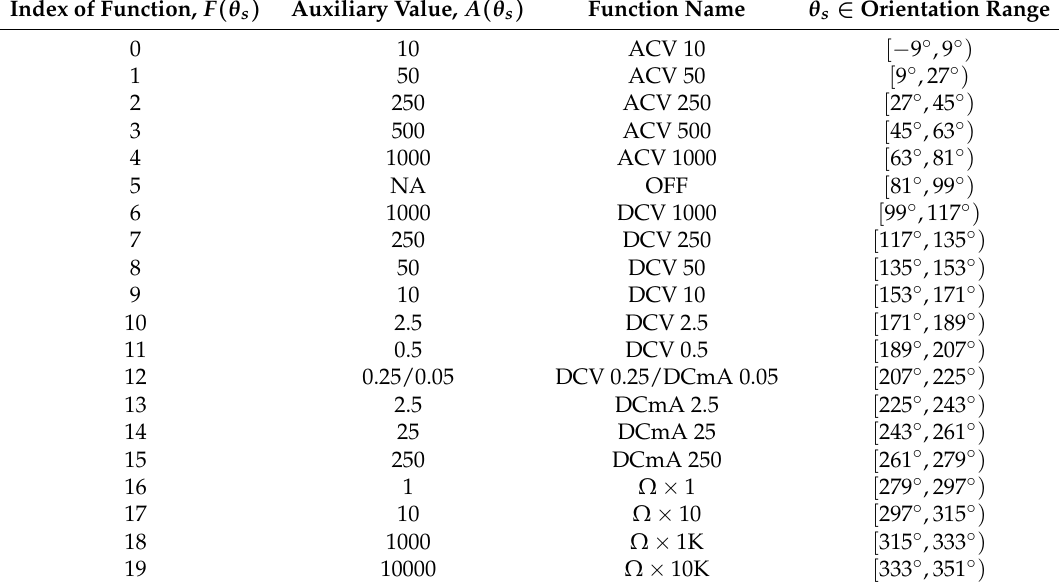
Table 1. The mapping table for the selector arrow built with the relationship between θ s and F ( θ s ) , based on Equation (1). Here, N = 20 and ∆ = 18 ◦ . The auxiliary value, A ( θ s ) , represents the maximum value used in linear cases (i.e., F ( θ s ) = 0,1, . . . ,15) and the multiplier used in nonlinear cases (i.e., F ( θ s ) = 16,17,18,19), respectively. Here “NA” denotes “not available.” Index of Function, F ( θ s